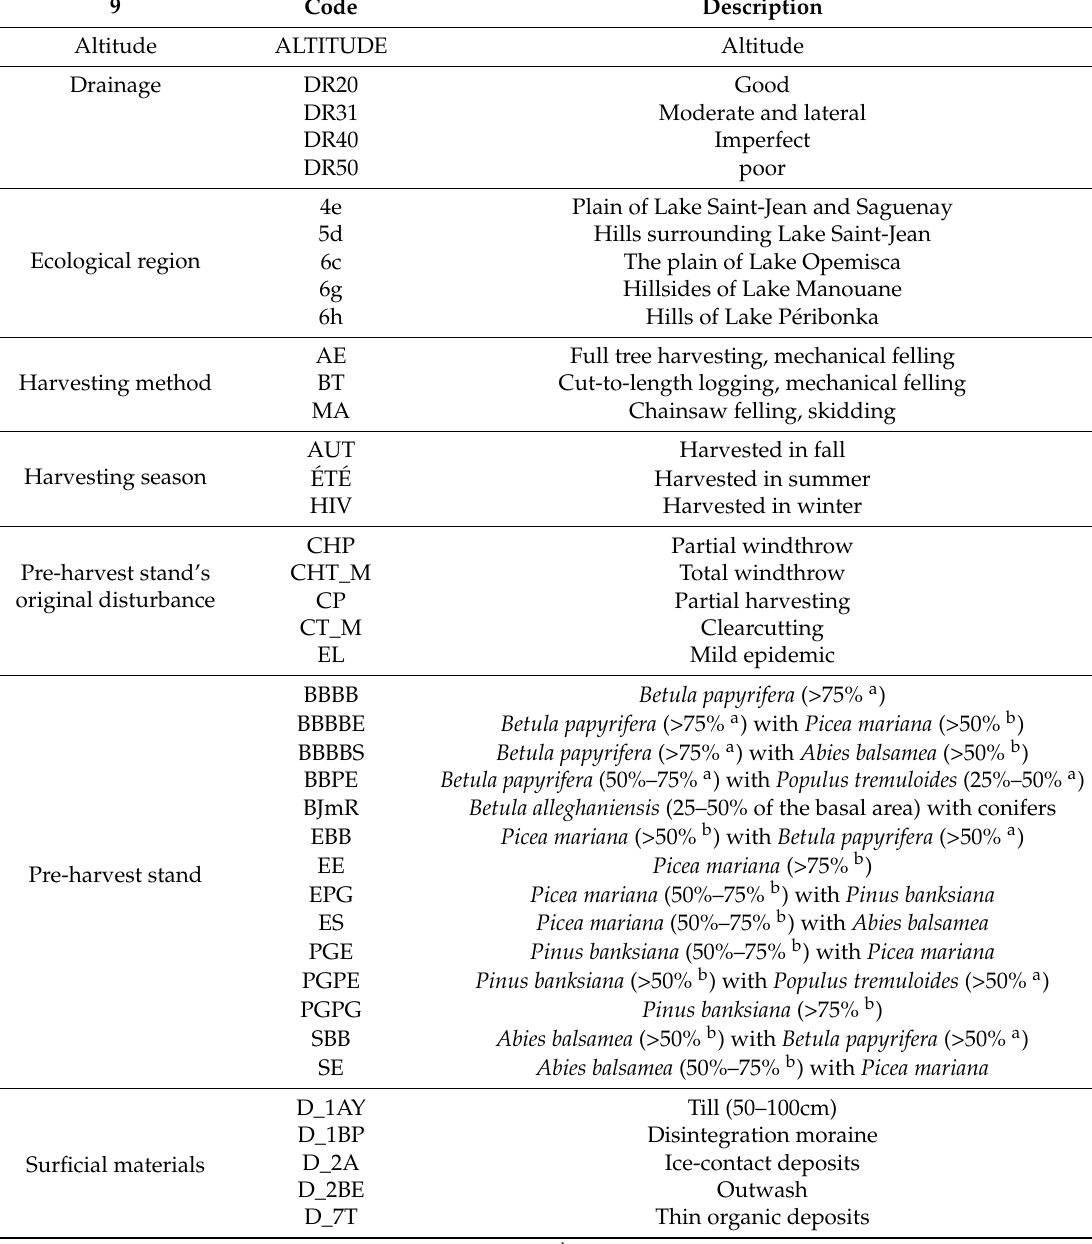
Table 2. Description of the independent variables identified in the redundancy analysis and later used in the linear mixed model and the cumulative link mixed